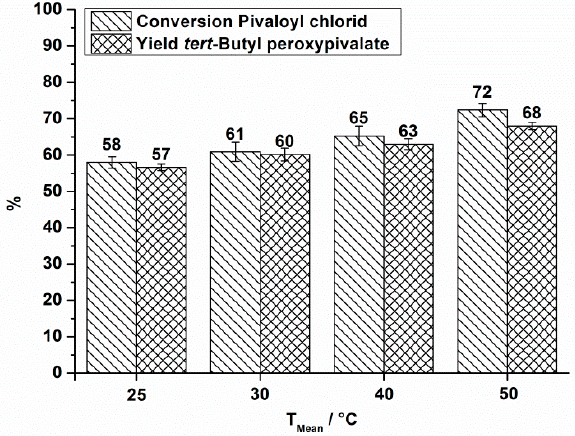
Figure 3: OMR, conversion and yield of TBPP synthesis, 2nd reaction step at a total flow rate of 10.5 mL·min − 1 depending on the reaction temperature.